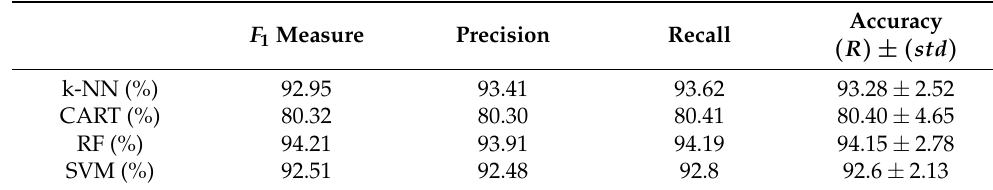
Table 4. F 1 -measure per class, F 1 -measure, precision, recall and average of accuracy rates ( R ) and its standard deviation ( std ) for each model (EMD raw).